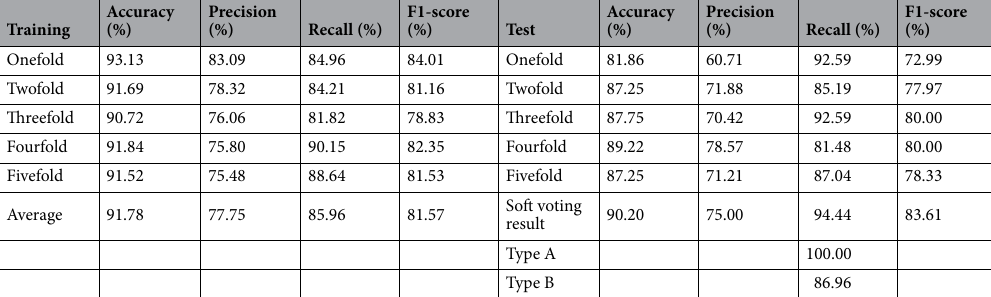
Table 3. Diagnostic performance matrix on the internal validation using fivefold validation and Test data set. Fivefold validation was performed with the dataset from hospital A and B. A hard voting method was used with five models from fivefold cross-validation to obtain the final classification result.